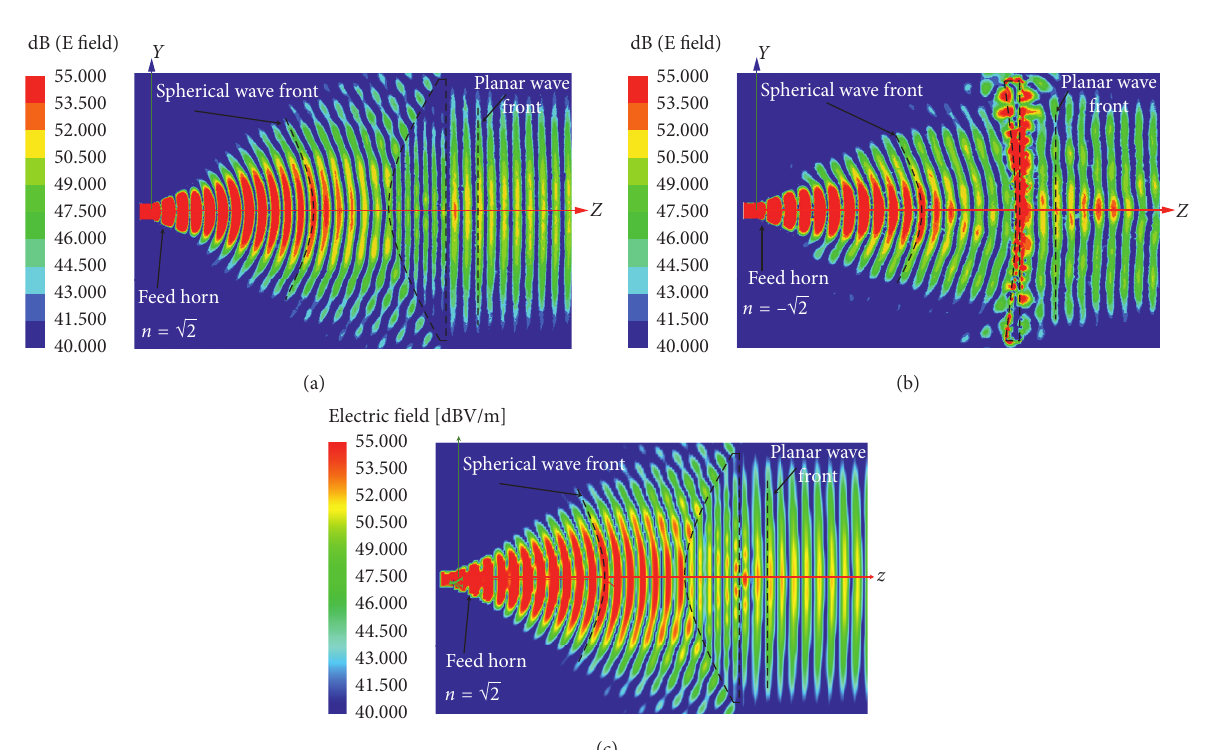
� √ 2 ). (b) NRI lens antenna ( n � −